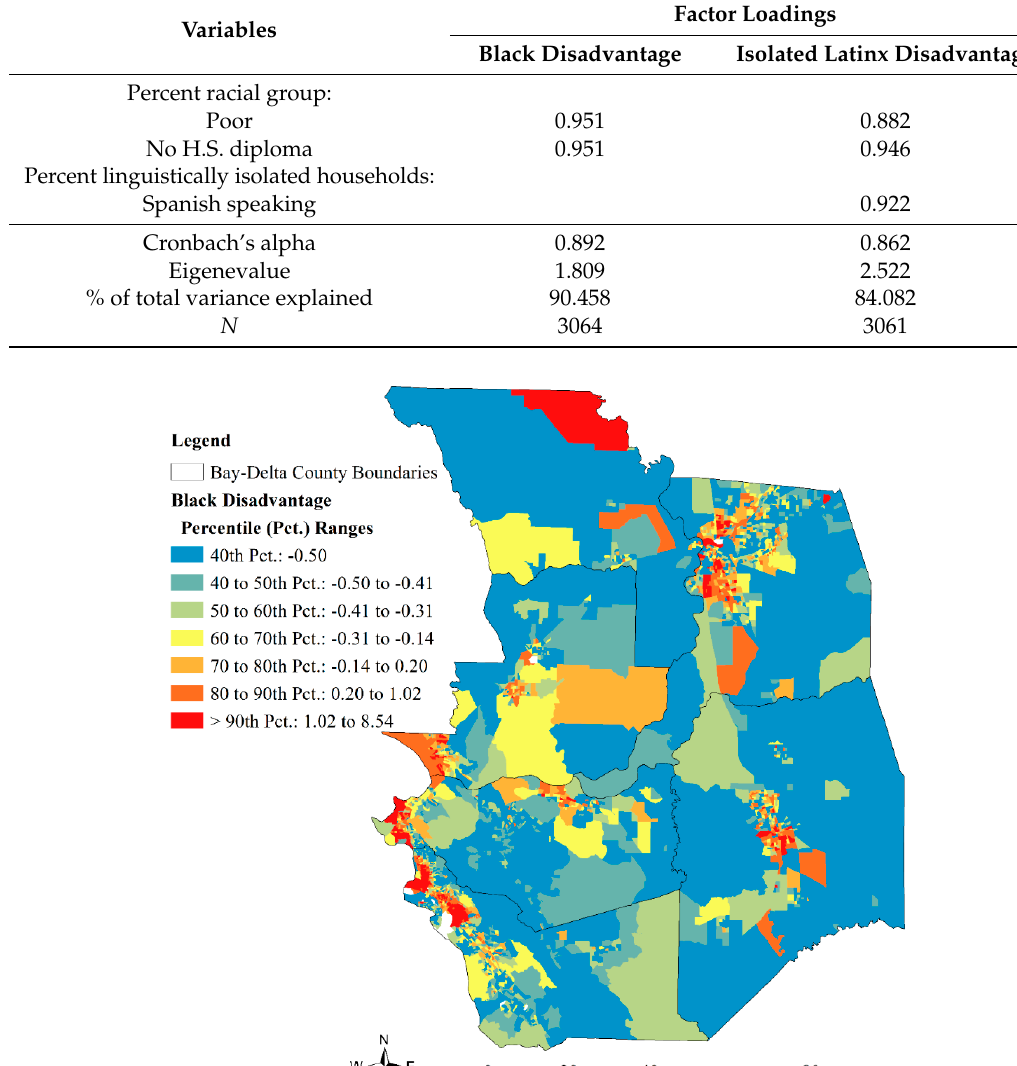
Table 1. Principal component analysis results for intersecting population vulnerability factor variables [3].